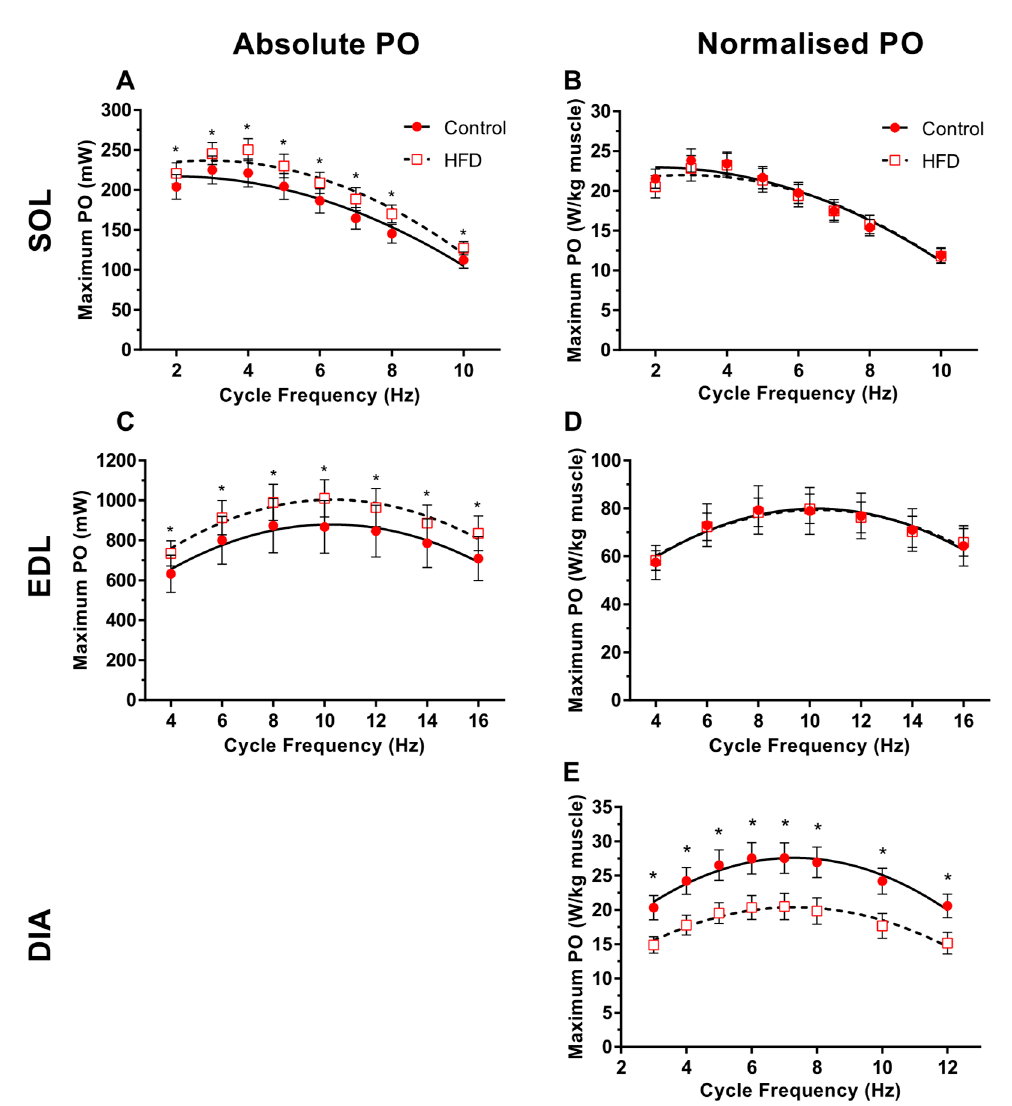
Figure 2. The effect of 9 weeks of a high-fat diet (HFD) on the power output-cycle frequency relationship for absolute power output (PO) (milliWatts; A , C ) and normalised PO (Watts per kilogram of muscle mass; B , D , E ) of isolated mouse soleus ( A , B ), EDL ( C , D ) and diaphragm ( E ) for the control or HFD groups. n = 10 per muscle. Absolute power is not presented for diaphragm due to slightly different segments of the diaphragm being used for each experiment. A * symbol denotes a significant difference in power output between each experimental group at a given cycle frequency.